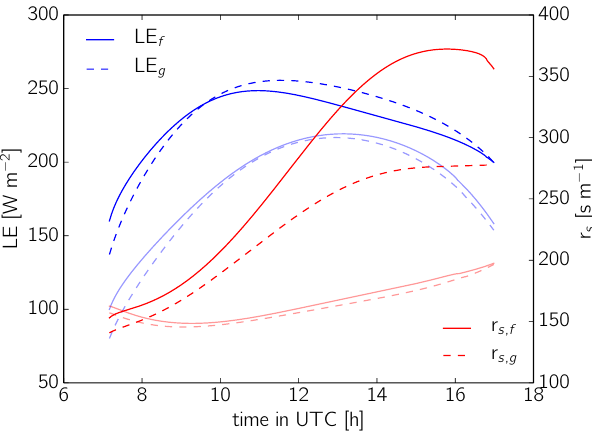
Figure 6. Time evolution of evapotranspiration LE and stomatal re- sistance r s under normal conditions (light shades) and heat wave conditions (dark